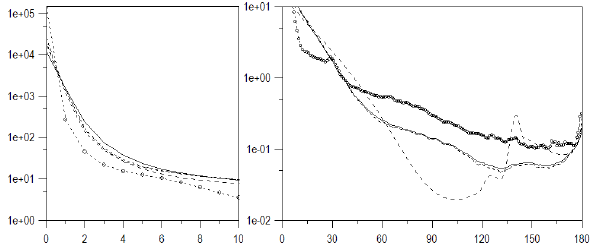
Fig. 9. Retrieved snow grain diameter from CAR BRF data for experiment 2001b. The right image shows the same data at reduced 40